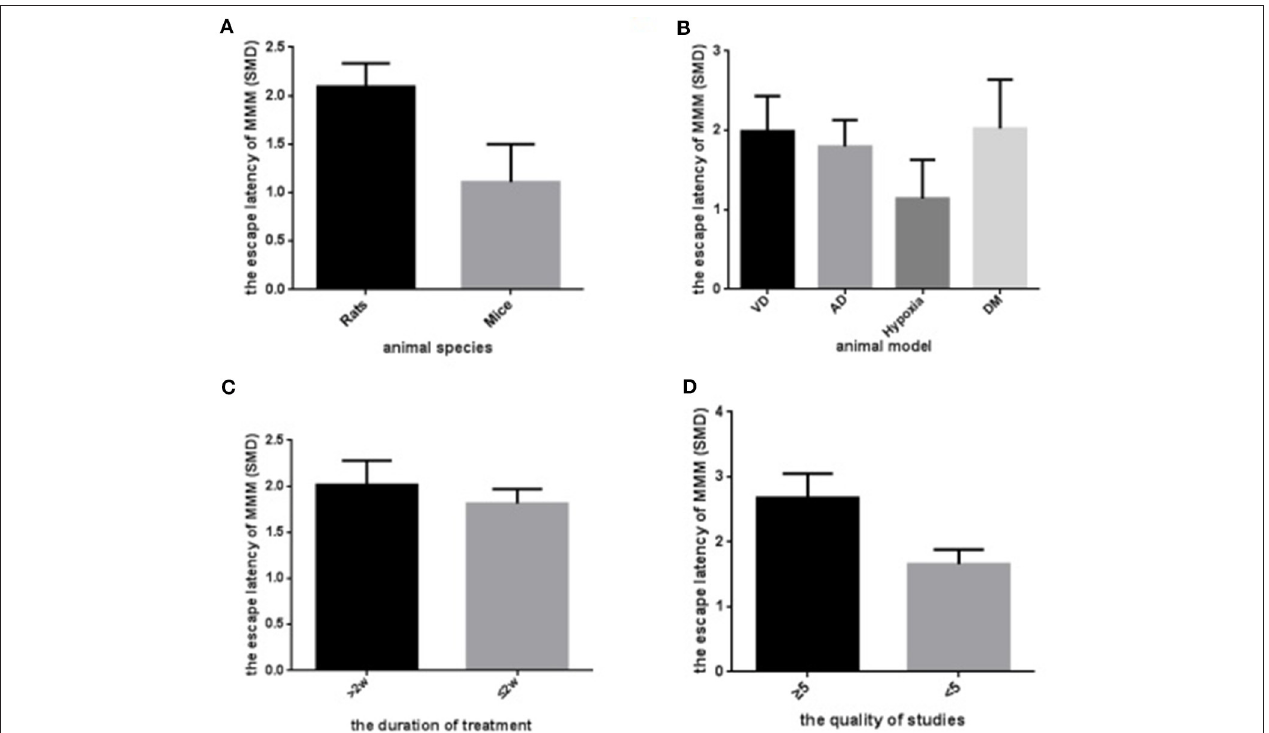
FIGURE 10 | Subgroup analyses of the escape latency. (A) The animal species on the effect size of the outcome measure; (B) the animal model on the effect size of the outcome measure; (C) the duration of the treatment on the effect size of the outcome measure; (D) the quality of studies on the effect size of the outcome measure. The magnitude of absolute value SMD reflected the effect size.